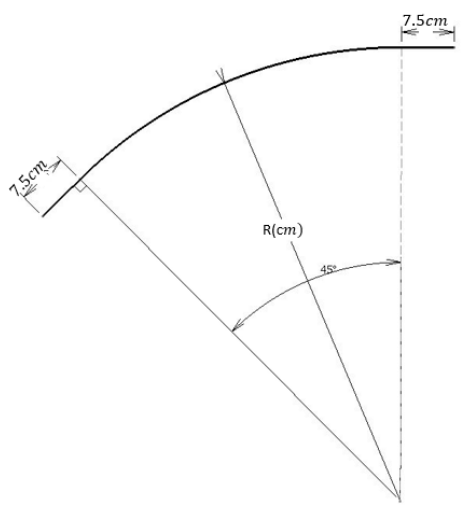
Figure 2. The tow’s path made by AFP machine’s software.